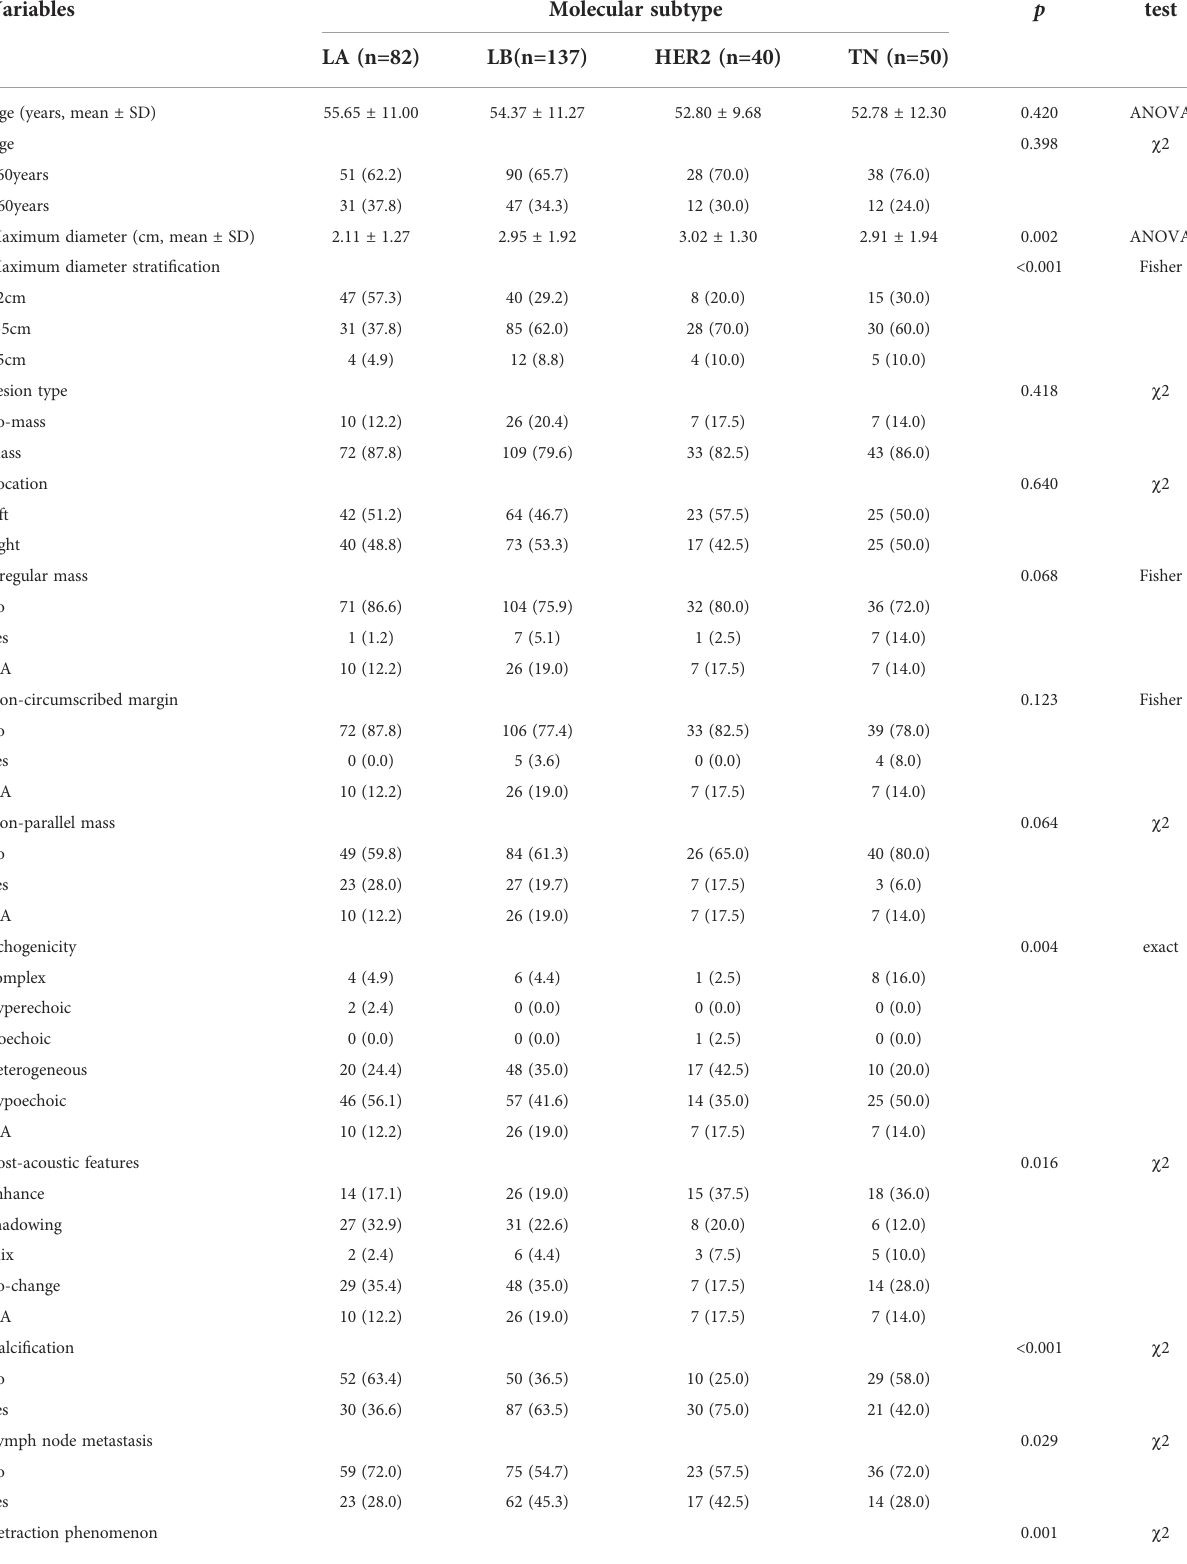
TABLE 2 Clinicopathological characteristics of patients with different molecular